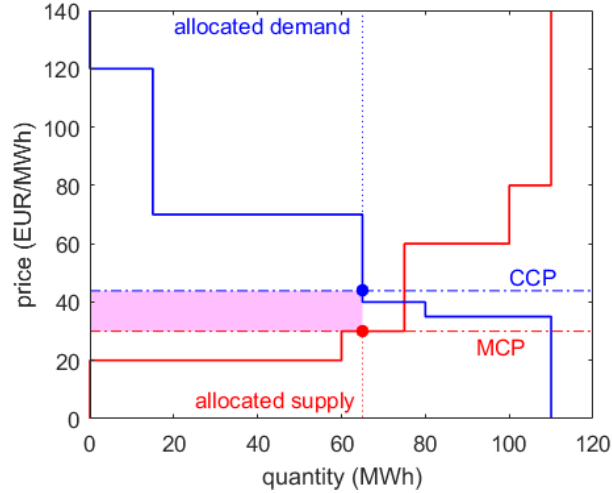
Figure 3. Illustration of the clearing example and its optimal results.